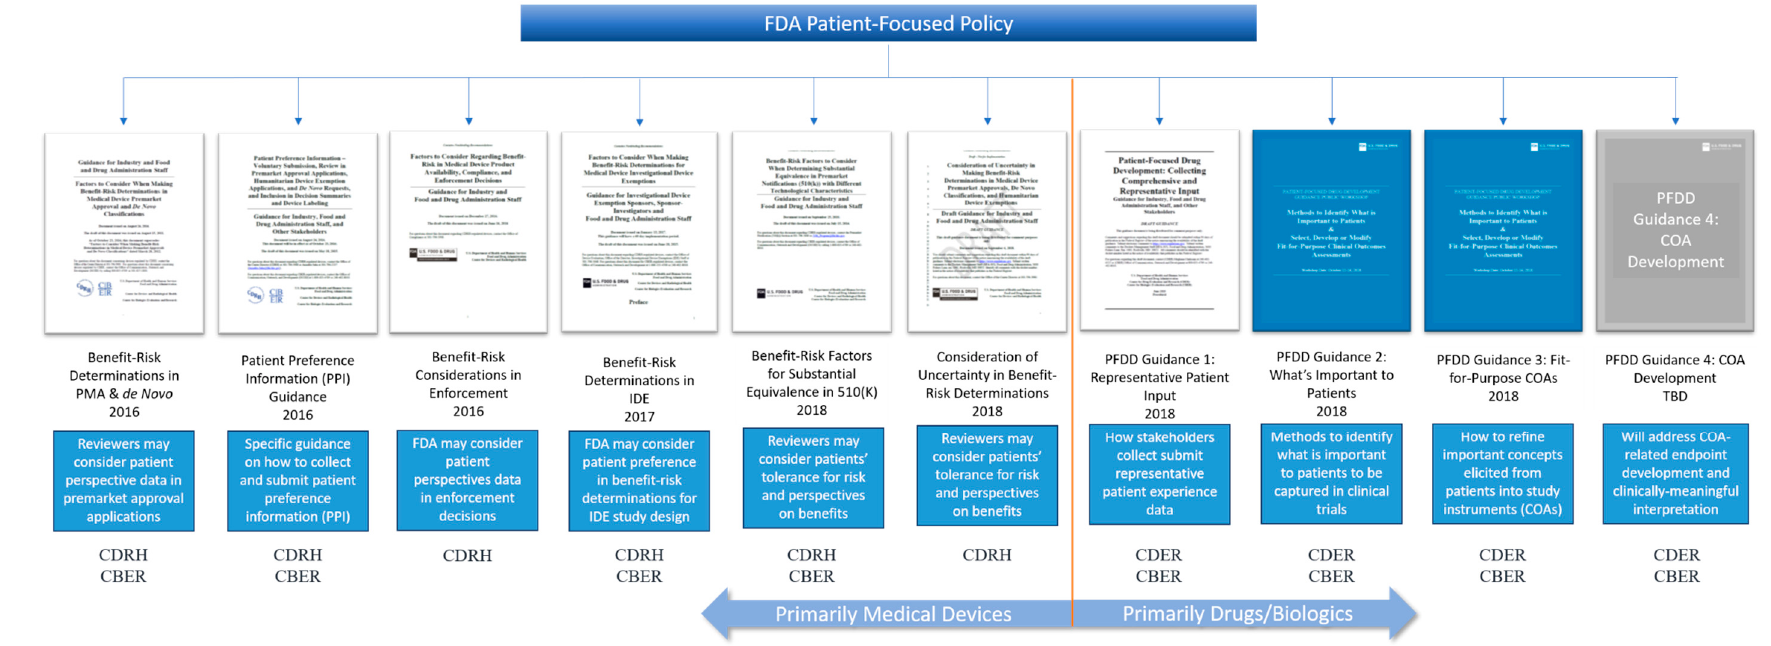
Figure 1. U. S. Food and Drug Administration (FDA) guidance on the use of patient preference or experience data in regulatory decision-making.